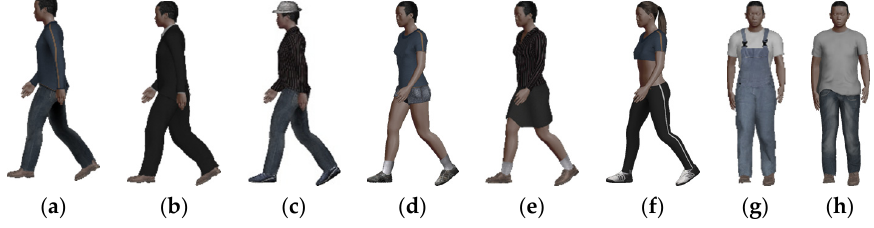
Figure 4. ( a )–( h ): Different clothing styles on 3D body. Figure 4. ( a – h ) Di ff erent clothing styles on 3D